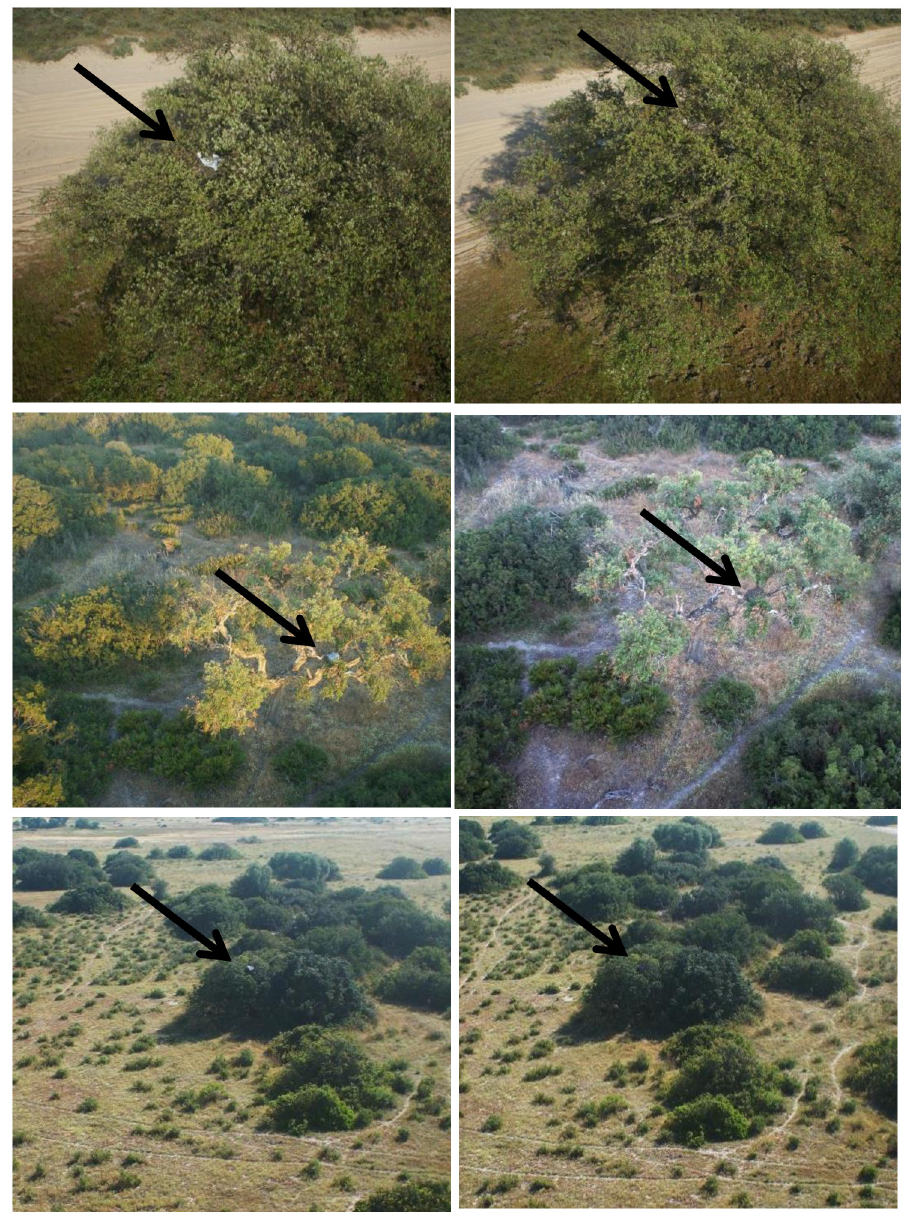
experimental decoration covered ca 80% of the nest platform, corresponding to a high-level of decoration in real nests, typical of birds in prime age (see [10]). Black arrows indicate the position of the nests. The images have been cropped and enlarged for illustrative